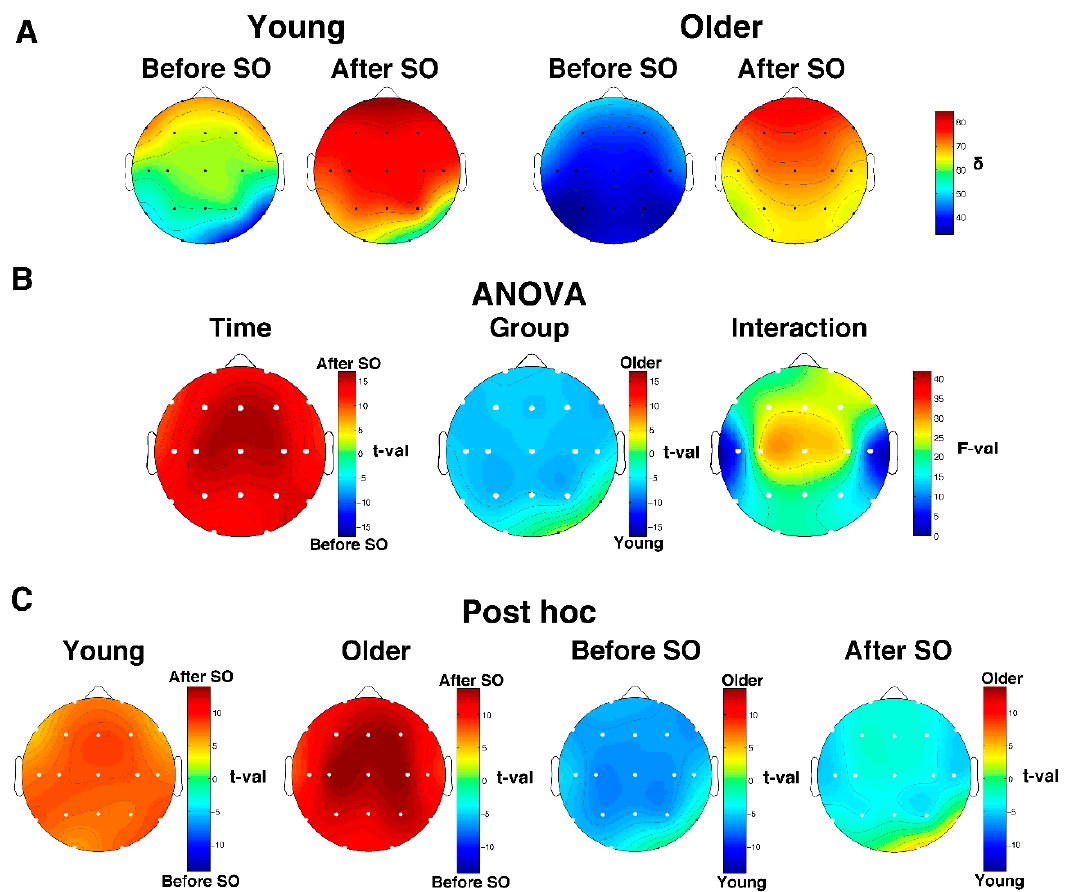
Figure 3. Relative SWA (0.5 – 4.75 Hz) power in young and older adults. ( A ) Topographical scalp maps of the SWA in the 5 min intervals before and after SO in young and older adults. The maps were scaled between minimal and maximal values calculated for all the derivations in pre- and post-SO periods in both age groups. ( B ) The results of the two-way mixed ANOVA on SWA values for each scalp derivation, with age (young vs. older adults) as the between-subject factor and time (before vs. after SO) as the within-subject factor. Results for the main effects of Group and Time are expressed in t -values corresponding to the original F -values [49], aiming to highlight the direction of differences. The sign of each t -value was defined by the difference between the mean values of the levels of each factor. Results for the effect of the interaction are expressed in F -values. White dots indicate significant differences after the FDR correction (critic p = 0.018). ( C ) Post hoc t -tests. White dots indicate significant differences.